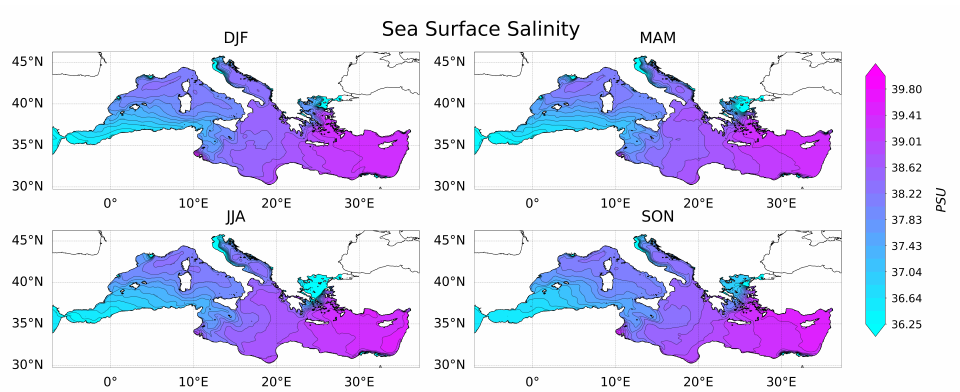
Figure 16. Seasonally averaged sea surface salinity from the NEMO simulation set.